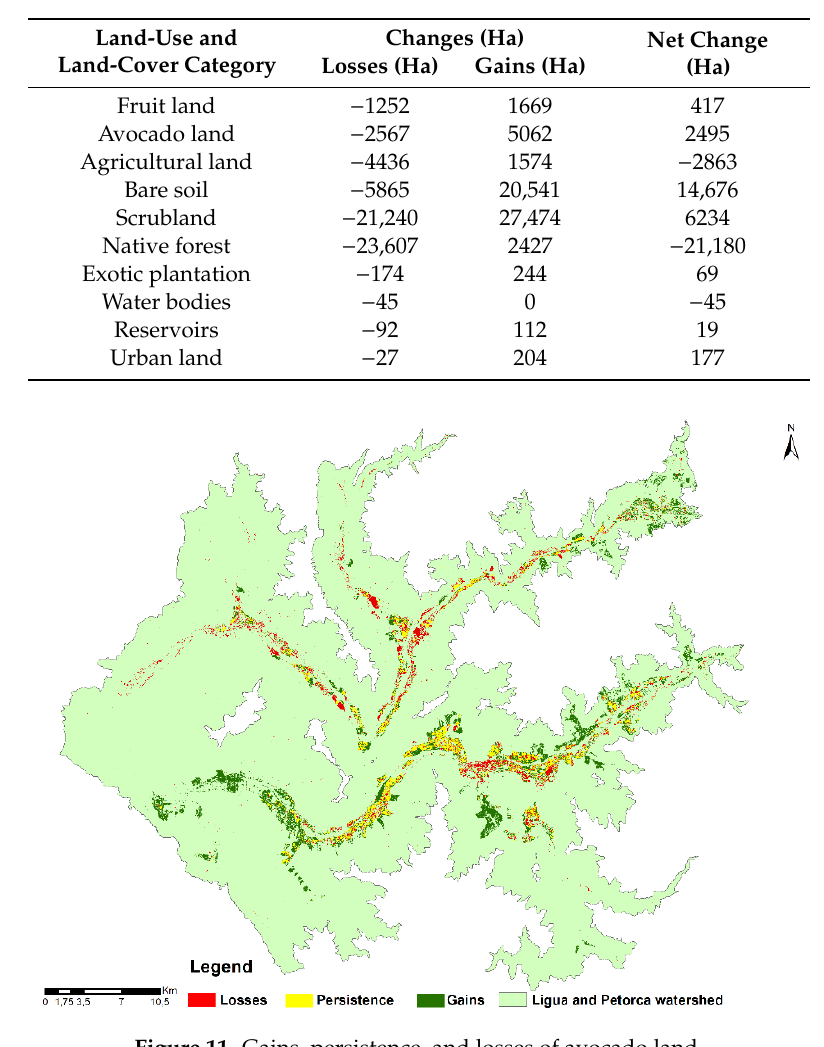
Table 4. Land-use change between 2002 and 2017.